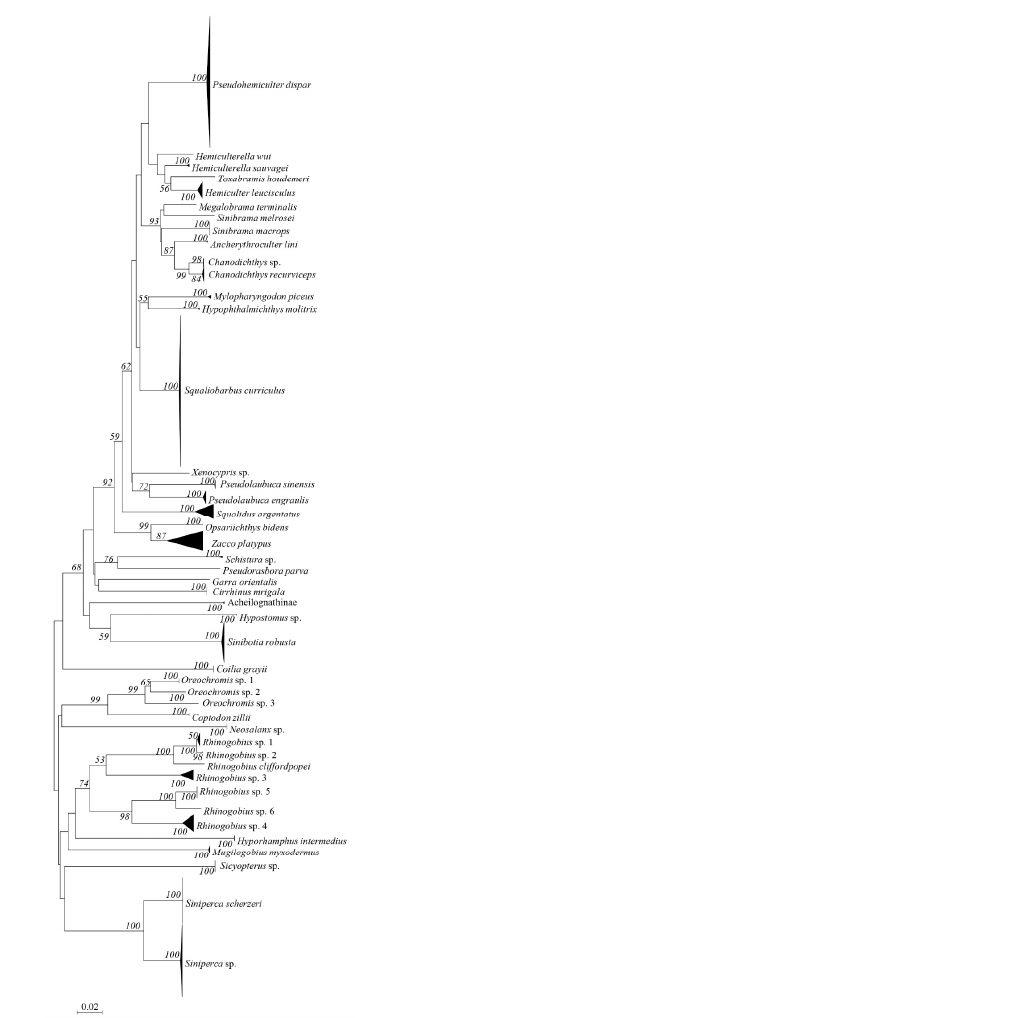
Figure 2. Neighbor-joining tree of 750 larvae. Bootstrap values are given at the